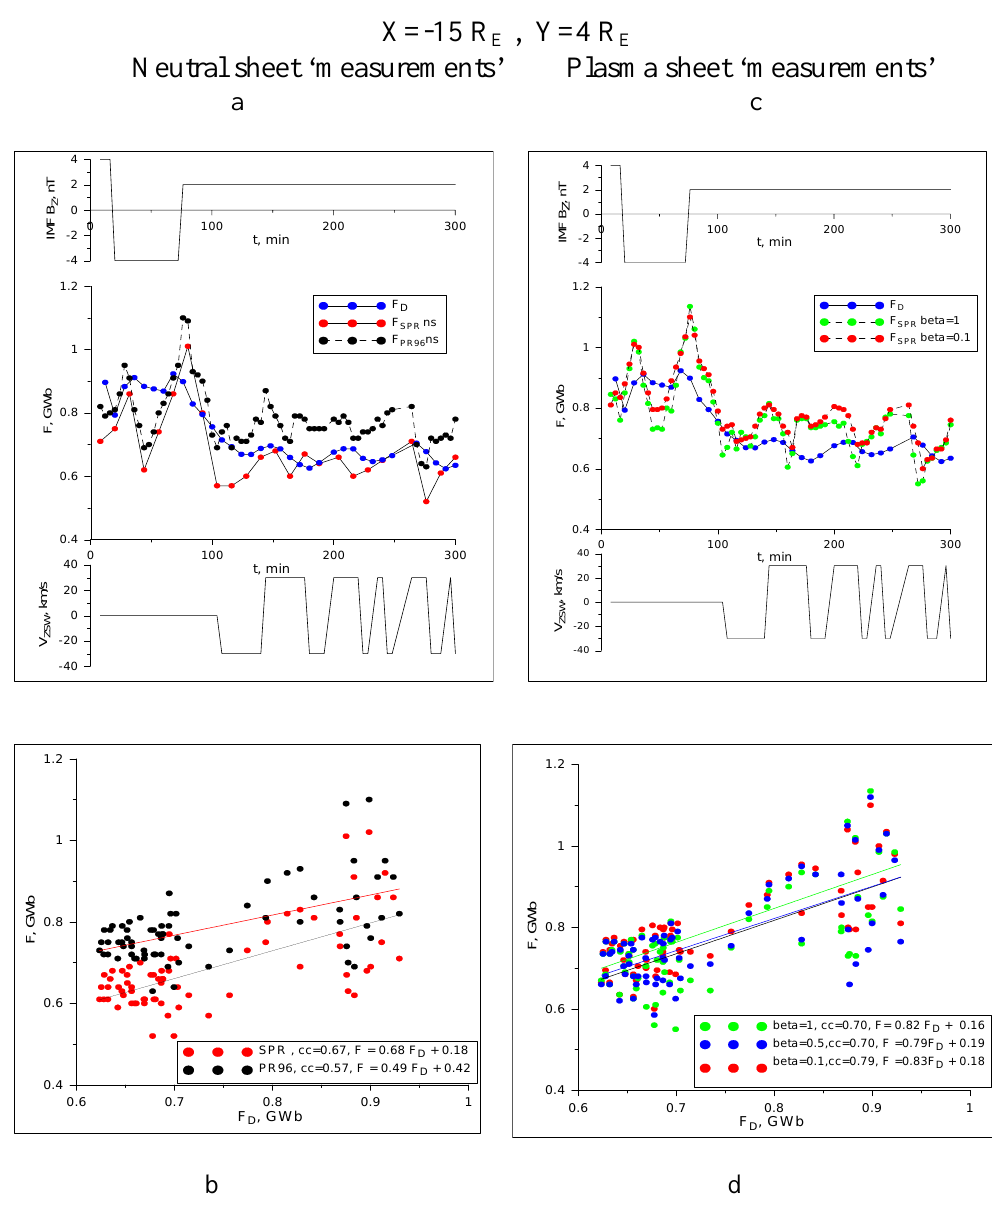
Fig. 4. Top: the same as in Fig. 3a, but for “observational point” in the neutral sheet (a) and in the plasma sheet (c) . Bottom: comparison of F values, calculated by different methods, for the “observational point” in the neutral sheet (b) , and in the plasma sheet with different beta values (d)